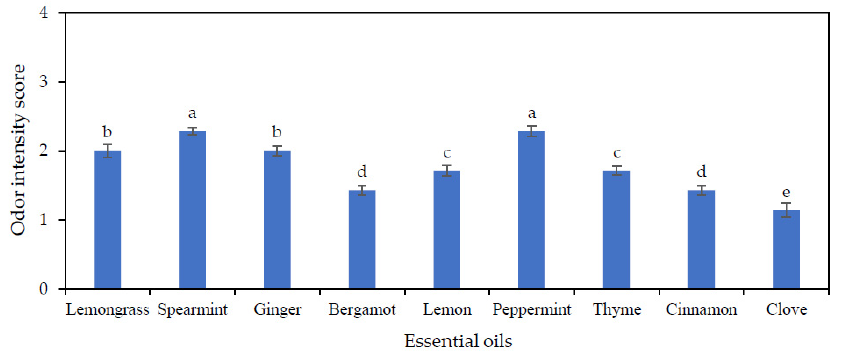
Figure 1. Screening of different essential oils (EOs) based on odor intensity score in table grapes. Values are mean ± standard deviation (n = 10). Different lowercase letters on the bars indicate a significant difference ( p < 0.05).